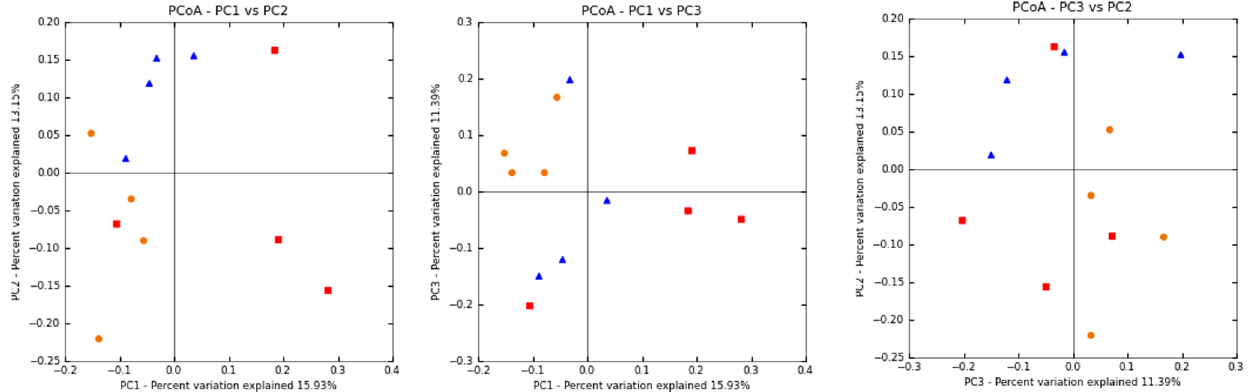
Figure 5. Principal Coordinate Analysis (PCoA) plots of the unweighted Unifrac distance matrix. The plots show each combination of the first three principal coordinates. Red (square): control; orange (circle): plum; blue (upright triangle):